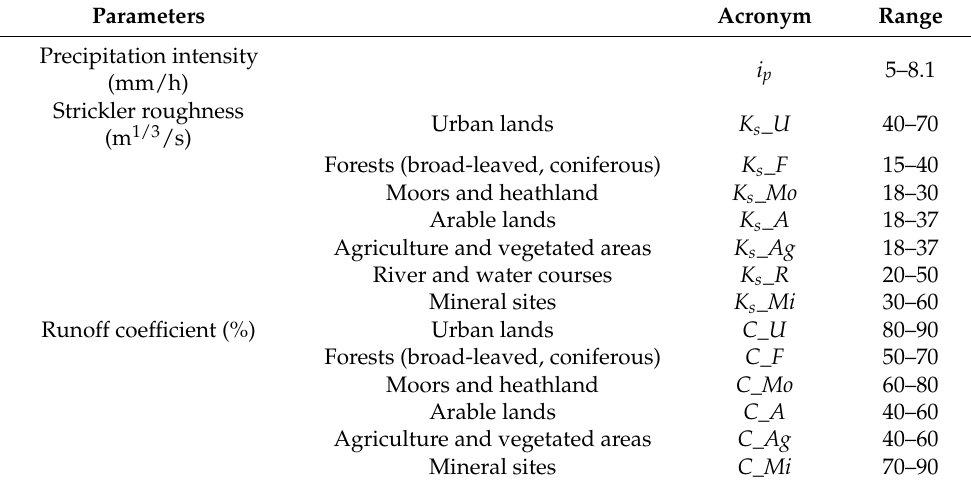
Table 1. Selected input descriptions and assigned